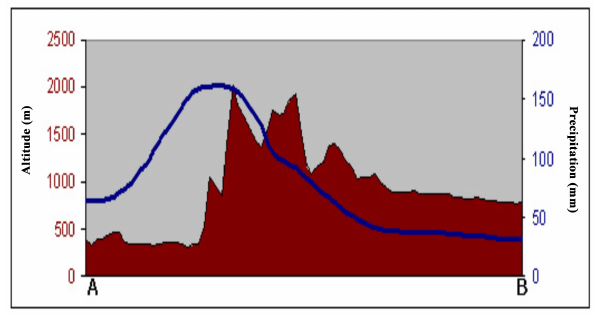
Figure 3. Average precipitation (all events) (line) and orographic (shaded) profiles along line AB (see Fig.